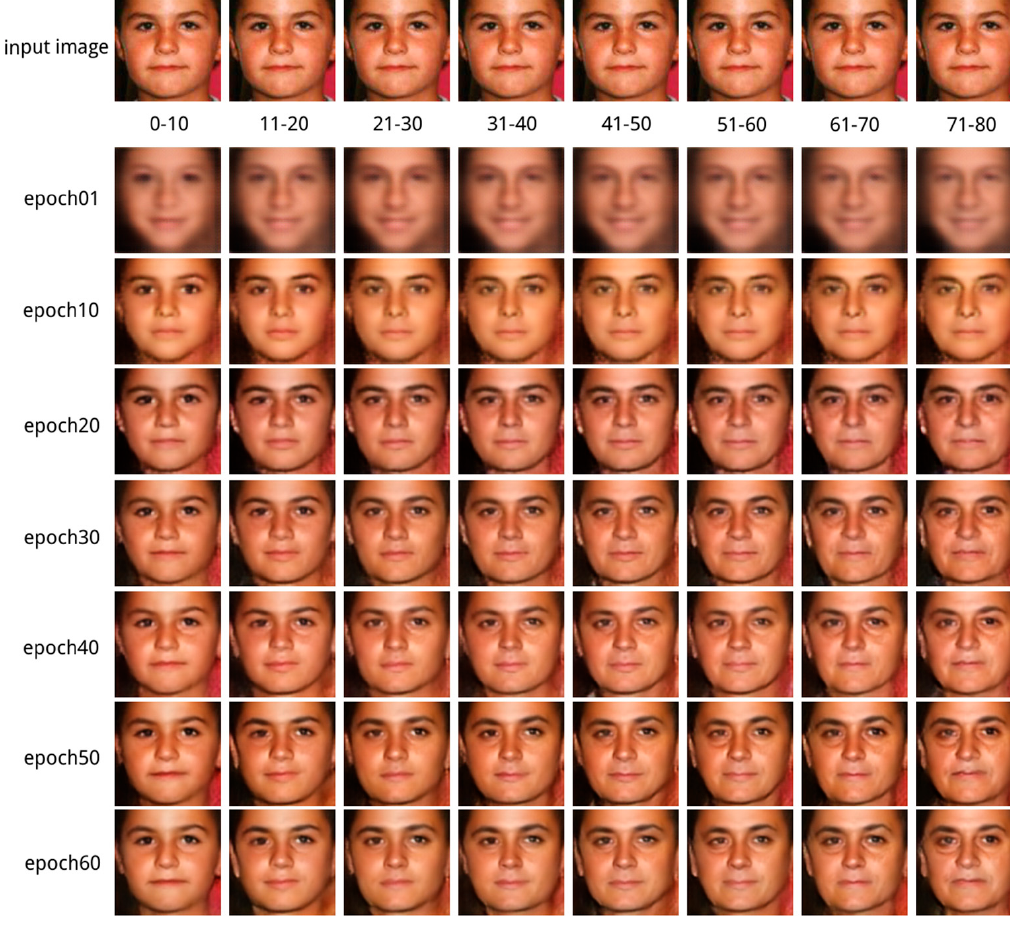
Figure 7. The Intermediate Model Generated by Iterative Training of Different Numbers and the Aging Synthesis Chart Generated by the Model.